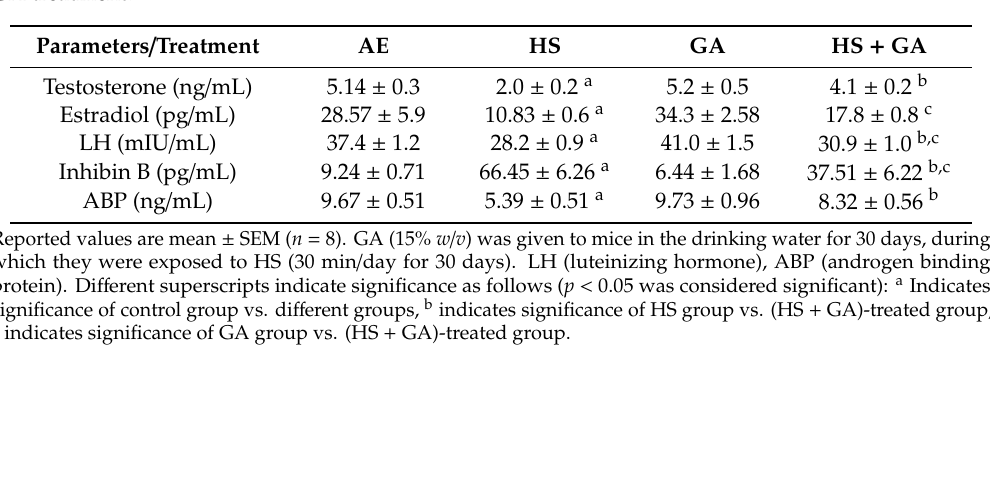
Table 2. Some plasma parameters in mice exposed to air (AE) or hookah smoke (HS) with or without GA